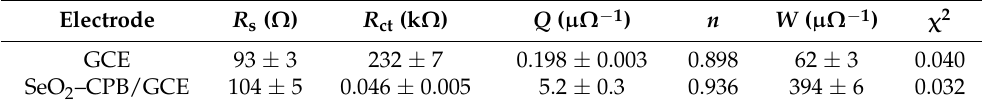
Figure 6. ( a ) Cyclic voltammograms for 1.0 mM [Fe(CN) 6 ] 4 − at the bare GCE (curve 2) and SeO 2 – CPB/GCE (curve 3) in 0.1 M KCl (curve 1), potential scan rate is 100 mV s ‒ 1 ; ( b ) Experimental (points) and fitted (lines) Nyquist plots for bare GCE and SeO 2 –CPB/GCE in the presence of 1.0 mM [Fe(CN) 6 ] 4 − /3 − in 0.1 M KCl. E = 0.22 V; frequency range, 10 kHz—0.04 Hz; amplitude, 5 mV. Table 1. Electrochemical impedance parameters of the electrodes ( n = 5; p = 0.95).